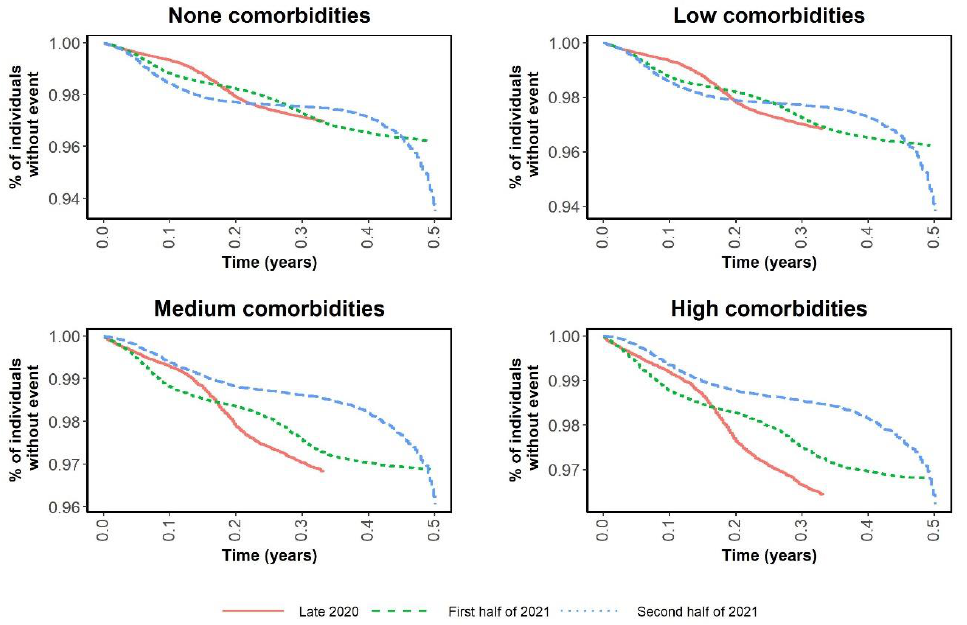
Figure 2. Kaplan – Meier curves of time to hospitalization according to socioeconomic level and pe- riod.